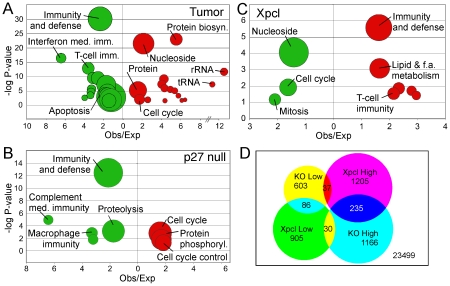
Gene expression associated with Xpcl1 integration and p27Kip1 null genotype.Biological function classes of the top 2500 genes associated with M-MuLV tumors vs. normal thymus (A) are shown in a circle plot with statistical significance plotted on the Y-axis and relative enrichment (observed/expected) plotted on the X-axis. Genes showing increased expression are shown (red) to the right and those with decreased expression (green) are plotted left of the Y-axis (P-values, binomial test). Circle diameters are proportional to the number of genes observed in each group. Within tumor samples, the functional classification of genes associated with (B) p27Kip1 null genotype or (C) Xpcl1 integrations are shown. A Venn diagram (D) shows limited overlap amongst genes exhibiting decreased expression in association with Xpcl1 integration (Xpcl1 Low) and simultaneously showing increased expression in p27Kip1 null tumors (KO High) (n = 30). Likewise, there is little overlap between the Xpcl1 High vs. KO Low sets (n = 37).